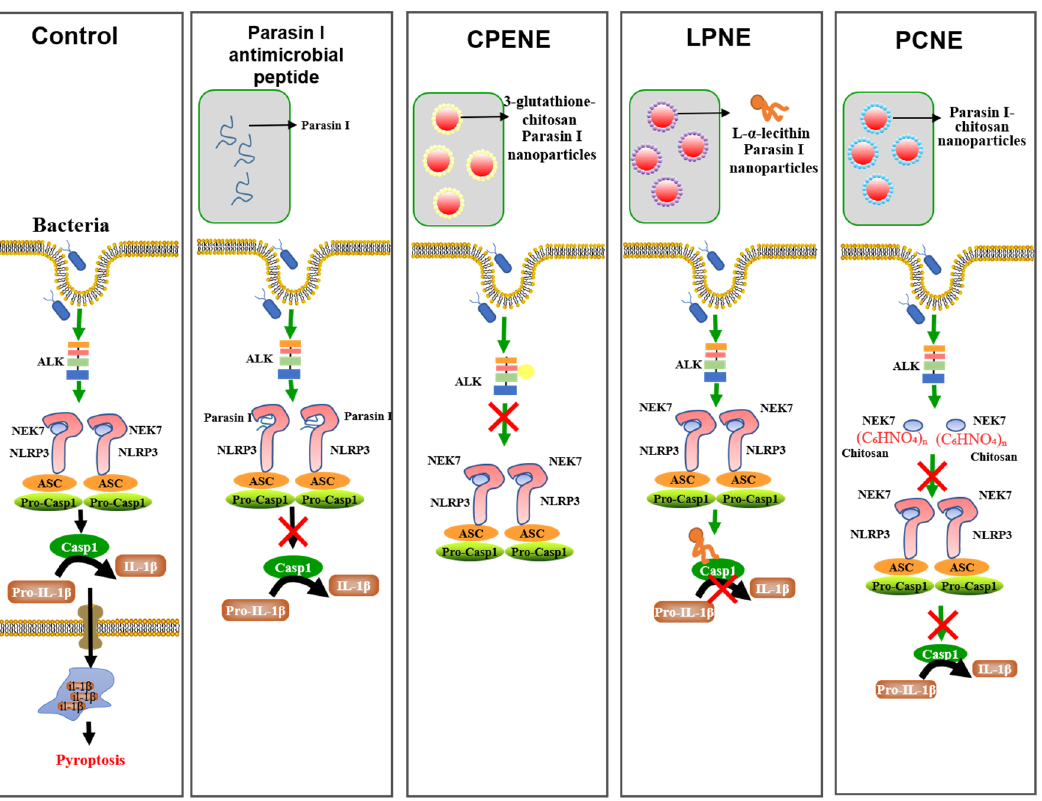
Scheme 2. The hypothesis of the effect of Pickering emulsions on the NLRP3 inflammasome activation and IL-1 β